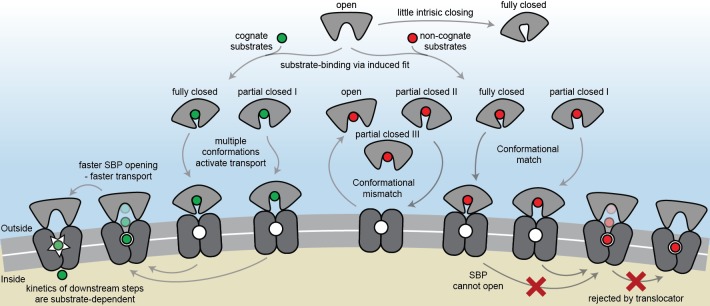
The conformational changes and dynamics of SBPs and the regulation of transport.Schematic summarizing the plasticity of ligand binding and solute import via ABC importers. Intrinsic closing of an SBP is a rare event or absent in some SBPs (‘little intrinsic closing’). Ligands are bound via induced fit (‘ligand-binding via induced fit’). SBPs can acquire one or more conformations that can activate transport (‘multiple conformations activate transport’). Variations in cognate substrate transport are caused by: (i) openings rate of the SBP and substrate transfer to the translocator (‘faster SBP opening – faster transport’) and (ii) substrate-dependent downstream steps (‘kinetics of downstream steps are substrate-dependent’). Although SBPs can acquire a conformation that activates transport (‘conformational match’), transport still fails when: (i) the SBP has no affinity for the translocator and/or cannot make the allosteric interaction with the translocator (‘conformational mismatch’); (ii) the SBP cannot open and release the substrate to the translocator (‘SBP cannot open’); or (iii) due to the specificity and size limitations of the translocator (‘rejected by translocator’).